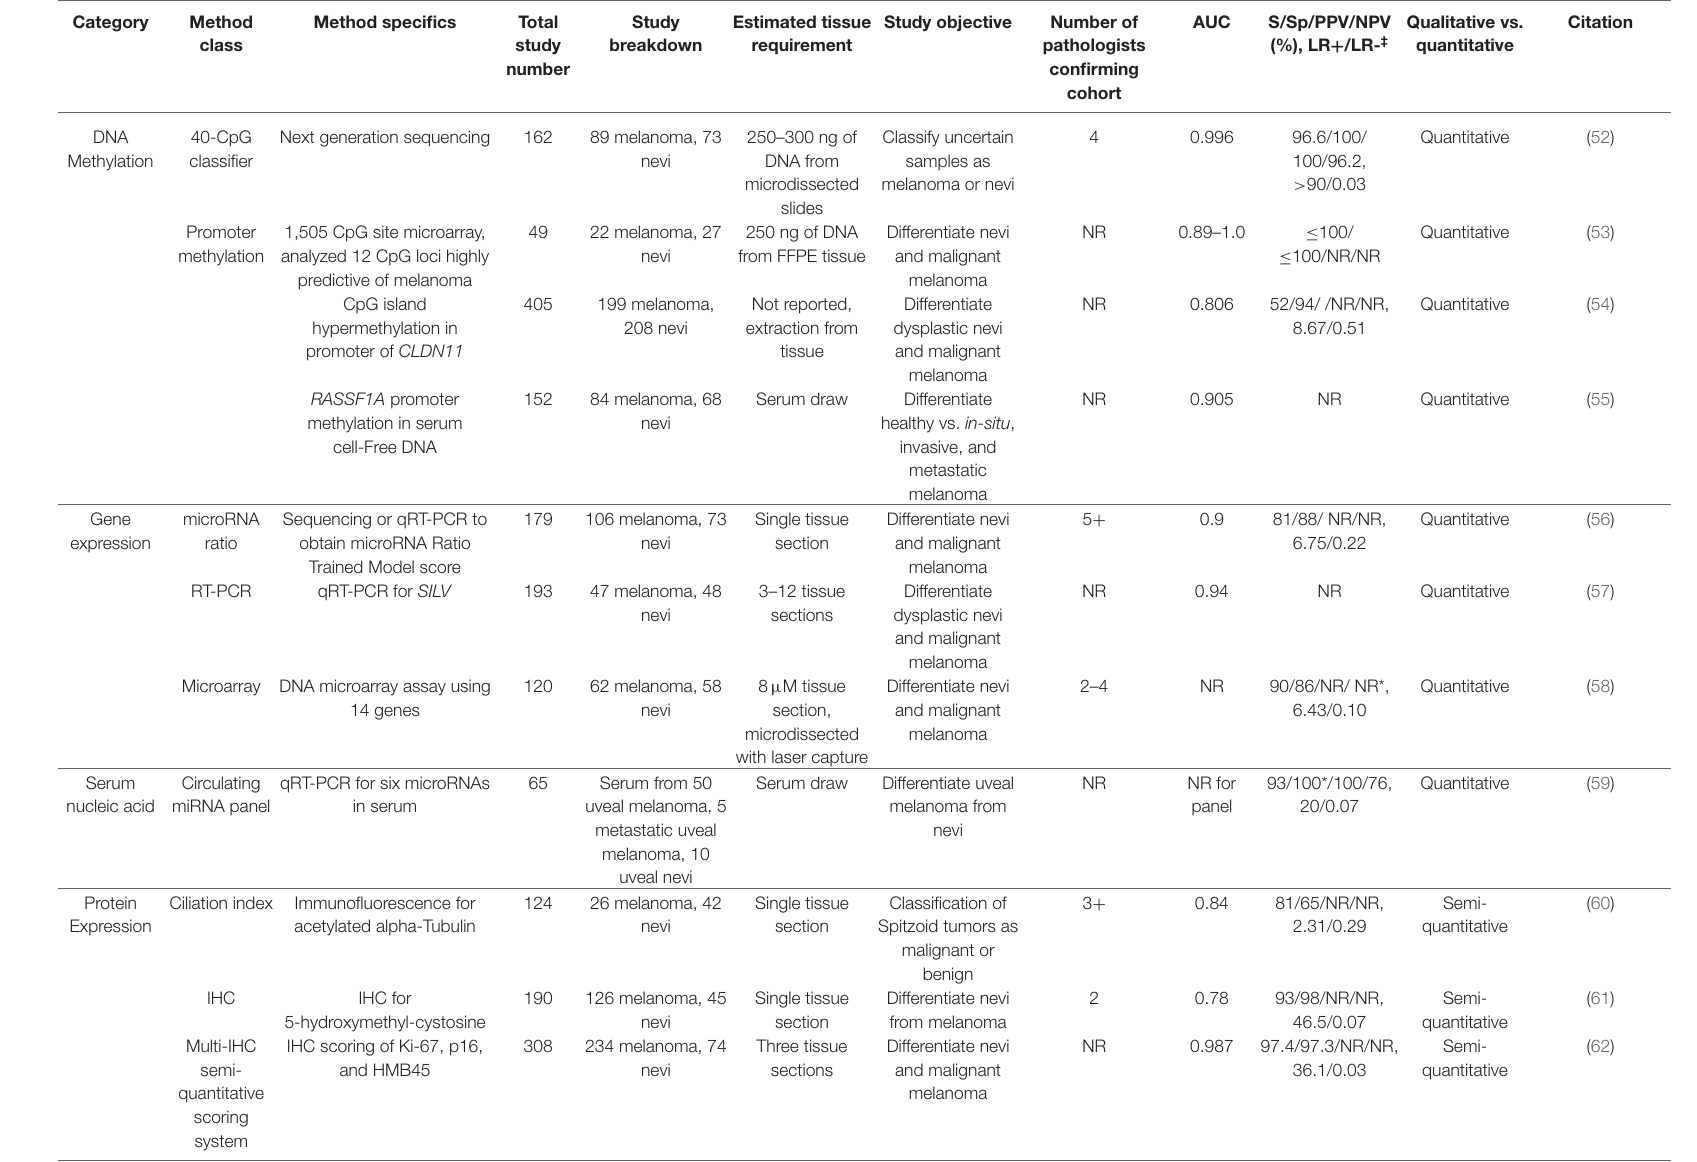
TABLE 3 | Proposed melanoma diagnosis biomarkers and prospective